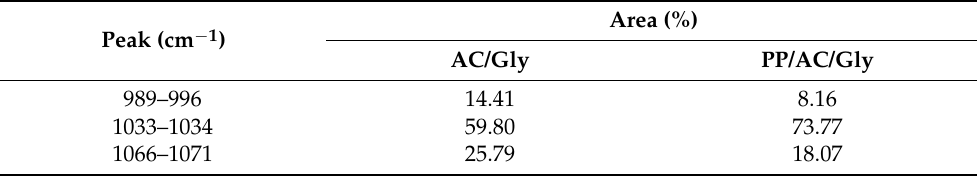
Table 2. Deconvoluted % of FT-IR data (ether functional group).